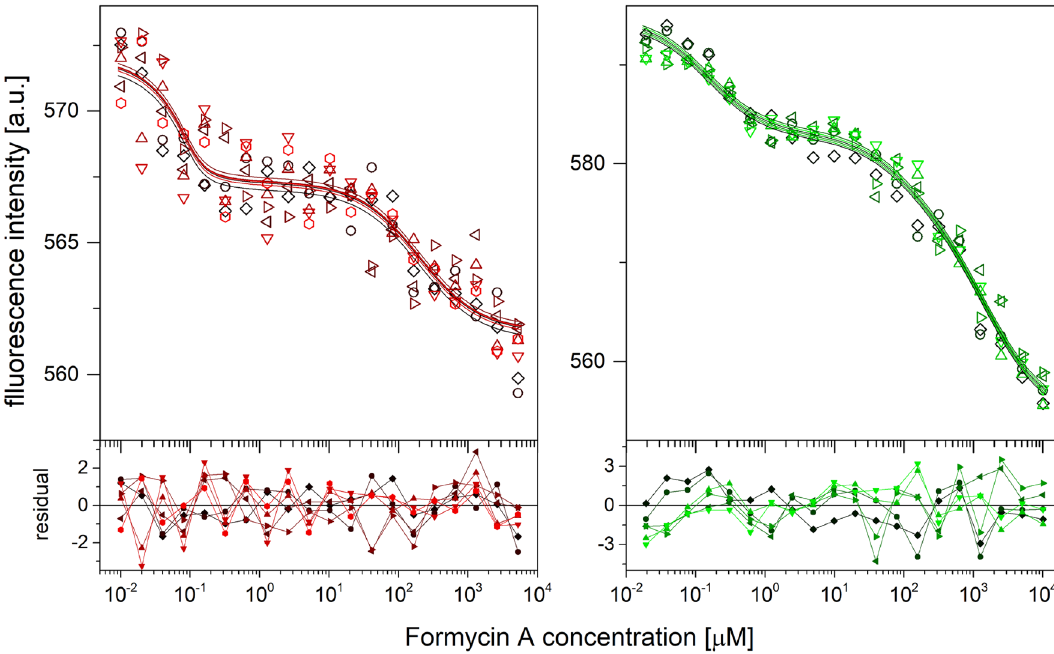
Figure 6. Thermophoretic titration curves of PNP-Pi complexes with formycin A: WT (left panel) and Y160W (right panel). Data (points), global best fit model (lines) and residual plots are presented. Titrations